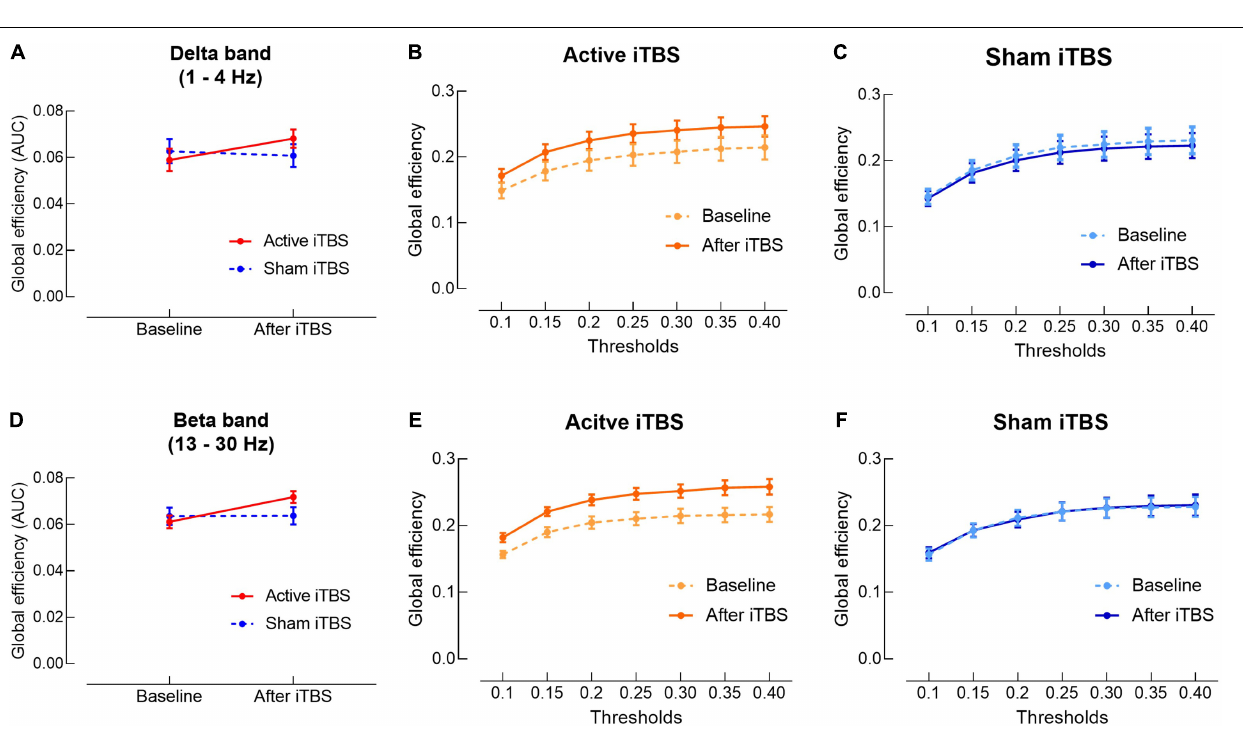
FIGURE 4 | Delta and beta bands global efficiency change after iTBS. Delta (A) and beta (D) bands global efficiency (area under the curves) were significantly increased in the Active iTBS group, but not in the Sham iTBS group after iTBS. (B,C) Delta band global efficiency at each threshold in the Active and Sham iTBS groups, respectively. (E,F) Beta band global efficiency at each threshold in the Active and Sham iTBS groups,